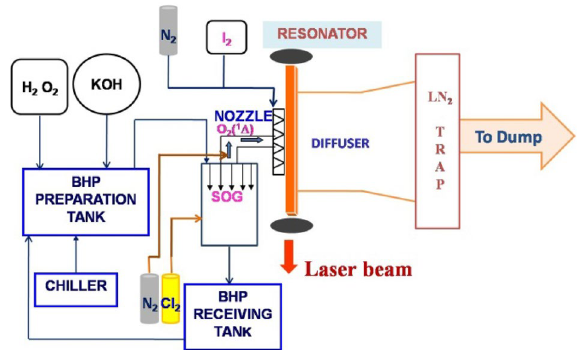
Figure 1. Basic COIL